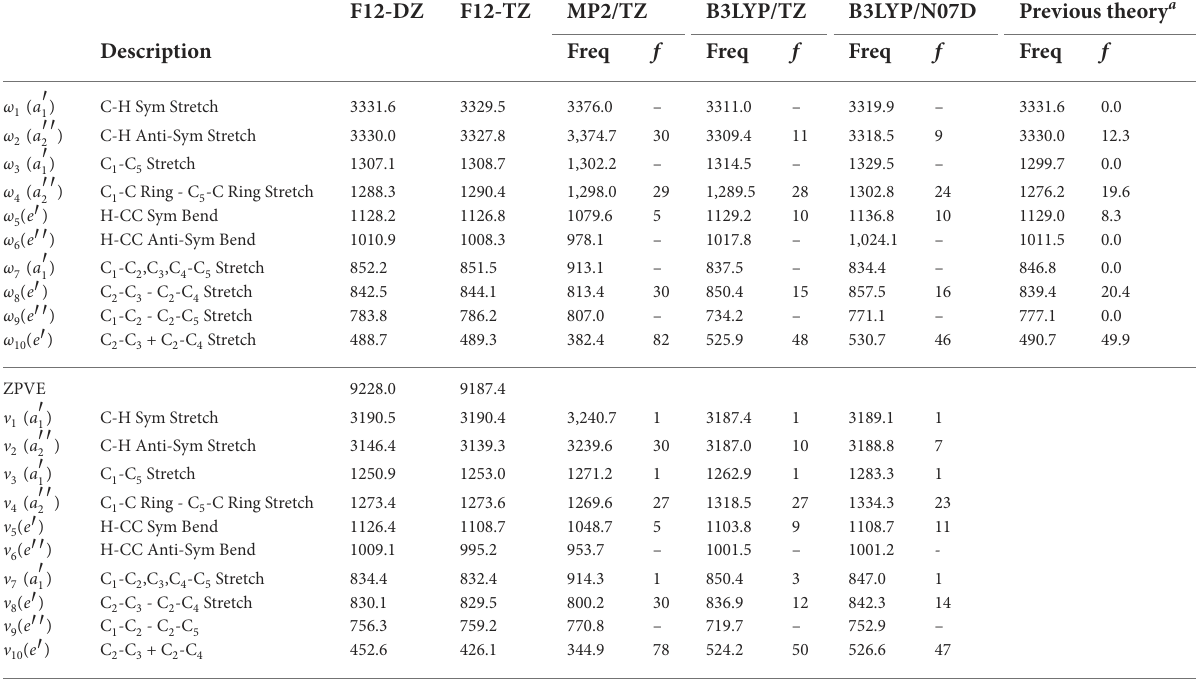
TABLE 8 F12-DZandF12-TZharmonicandfundamentalfrequenciesofbipyramidalC 5 H 2 withintensitiesinkm mol −1 comparedtoprevioustheory computedatthefc-CCSD(T)/cc-pVTZleveloftheory a